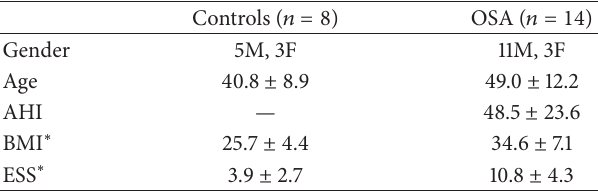
Table 1: Demographics for controls and sleep